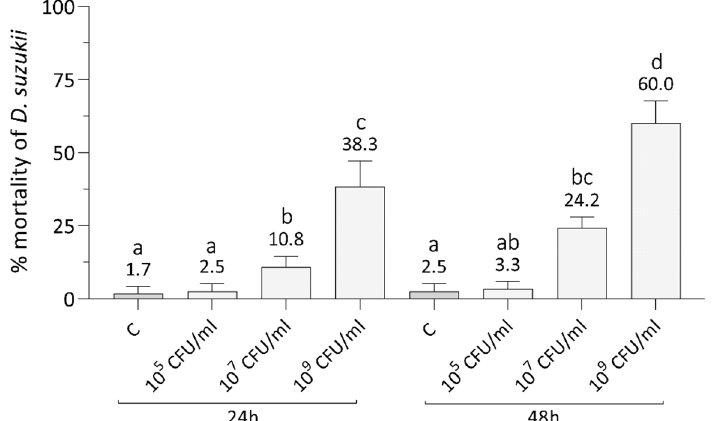
Figure 1. Effects of the oral administration of various concentrations of X. nematophila to L1 larval stages of SWD. A marked increase of mortality compared to the control (C) was observed only with a bacterial load of 10 9 CFU/mL, causing a mortality higher than 50% at 48 h. Letters (a–d) indicate significant differences in the pairwise comparisons (Tukey test, p < 0.05, see Table